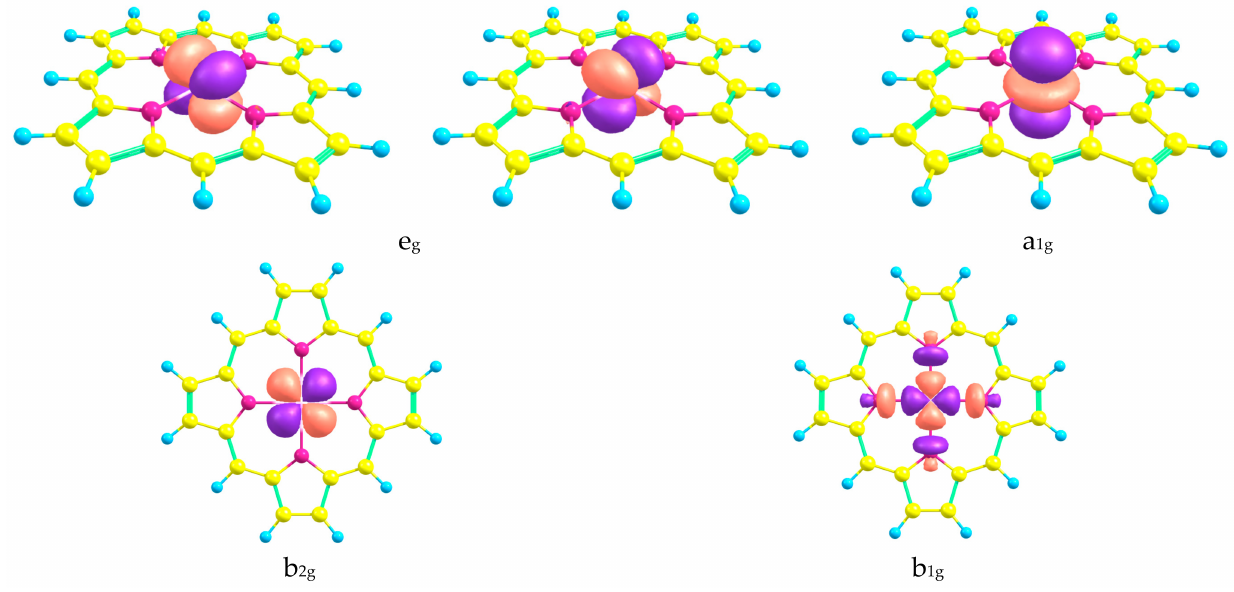
Figure 2. Shapes of active CASSCF molecular orbitals of FeP